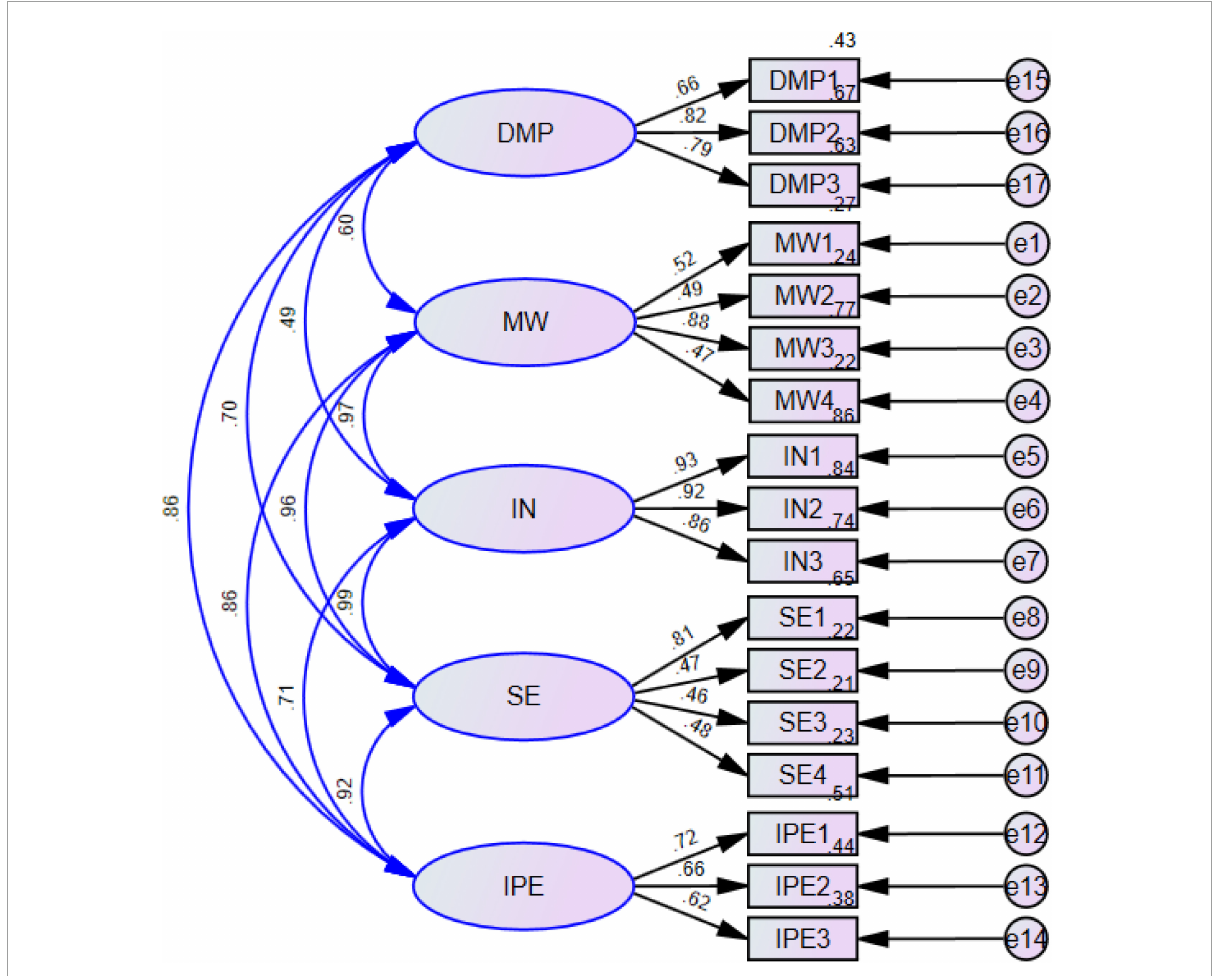
FIGURE2 Measurement model. MW, mental workload; IN, intention; SE, self-efficacy; IPE, innovation in physical education; DMP, decision-making